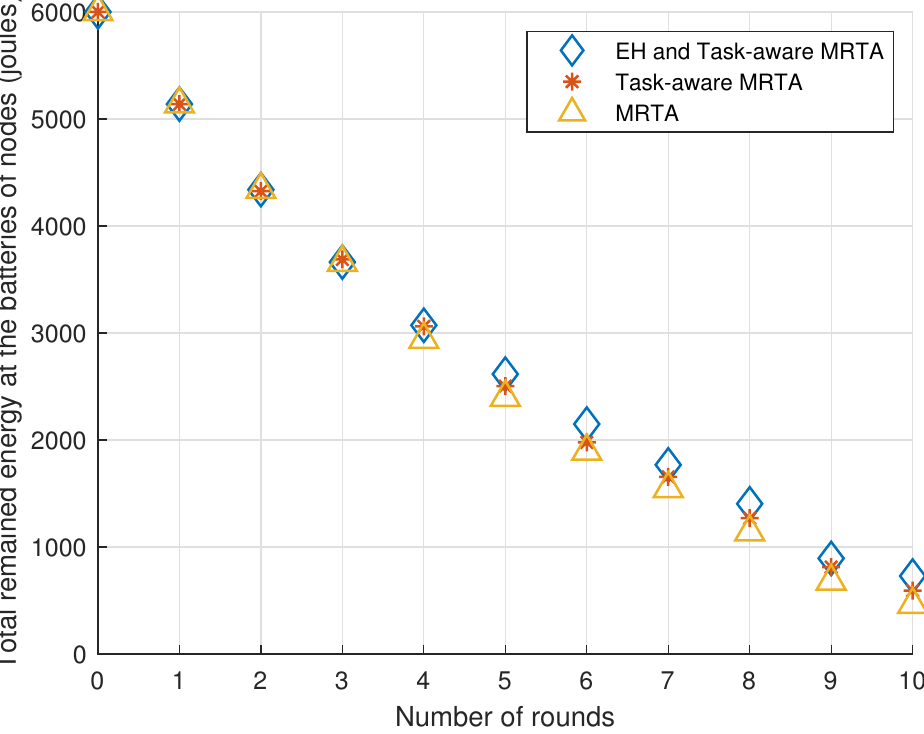
Figure 9. Total remaining energy in the batteries of the 10 robot nodes versus the number of rounds under Markov EH processes.